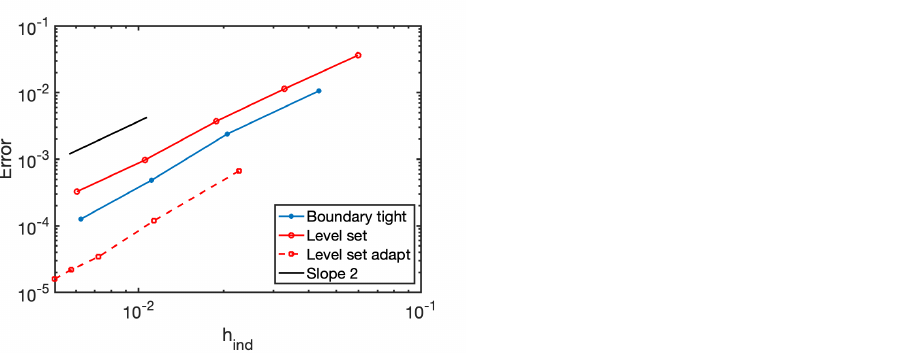
Figure 14. L 2 − error vs. size indicator (logarithmic scale) of the conformal, level set and adaptive level set